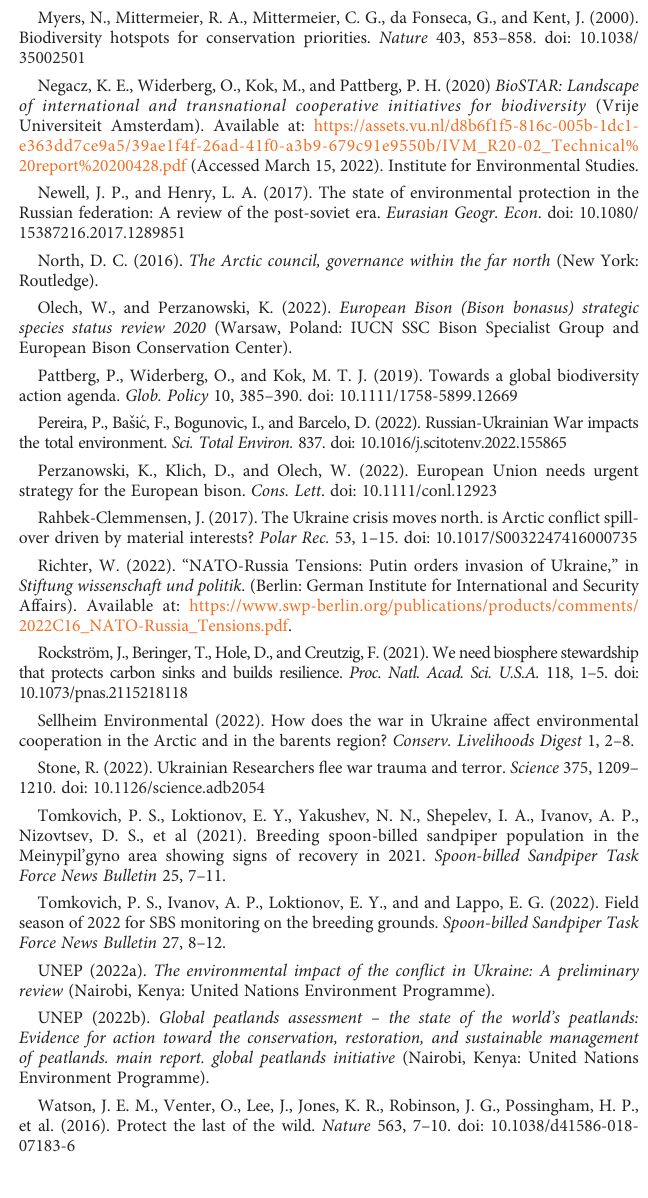
SUPPLEMENTARY INFORMATION 4 List of subsidiary institutional arrangements under the Convention on Migratory Species for which Russia is a range state but not a member.